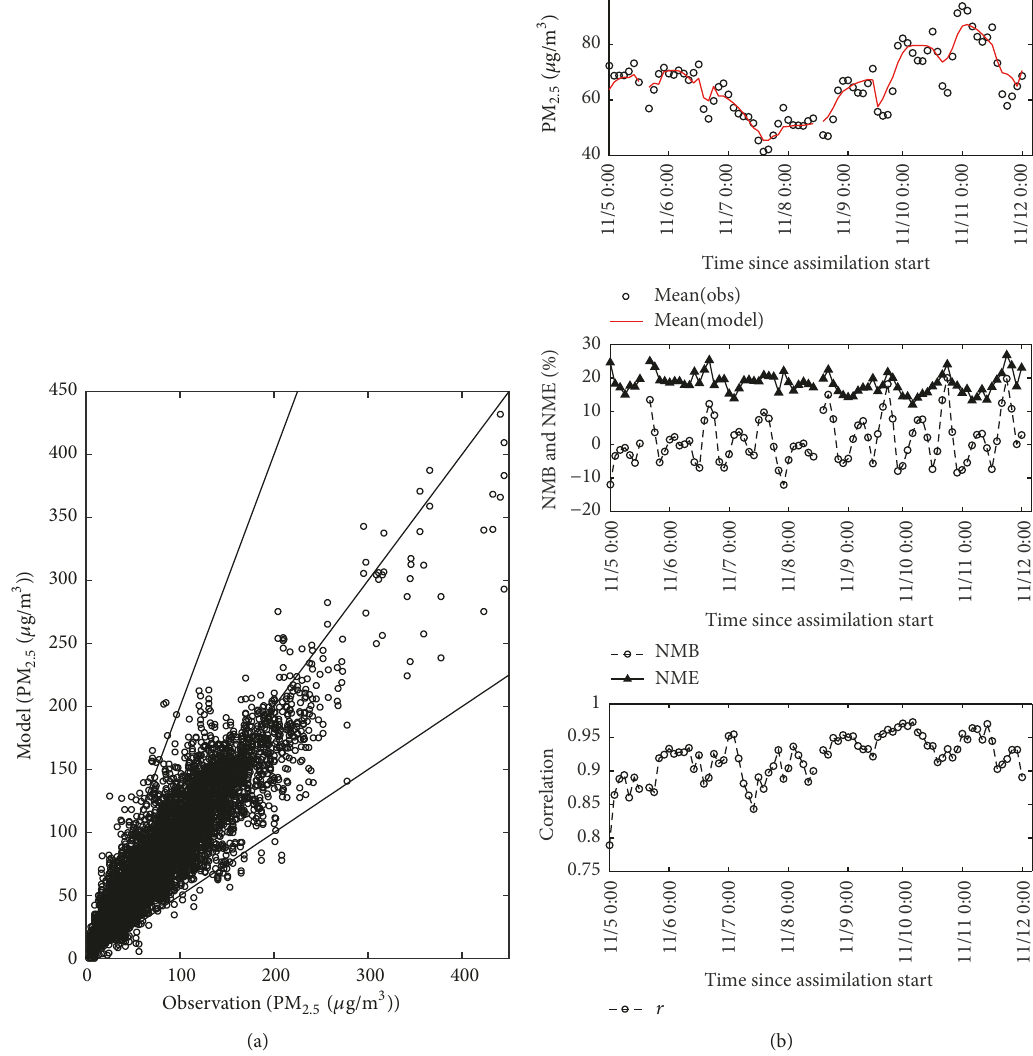
Figure 6: Comparison of the modeled and observed PM 2.5 concentrations based on the results from the PPM (4) : (a) scatterplot ( 𝜇 g/m 3 ) (the 1: 2, 1: 1, and 2: 1 lines are shown for reference); (b) temporal variation of domain mean, NMB, NME, and